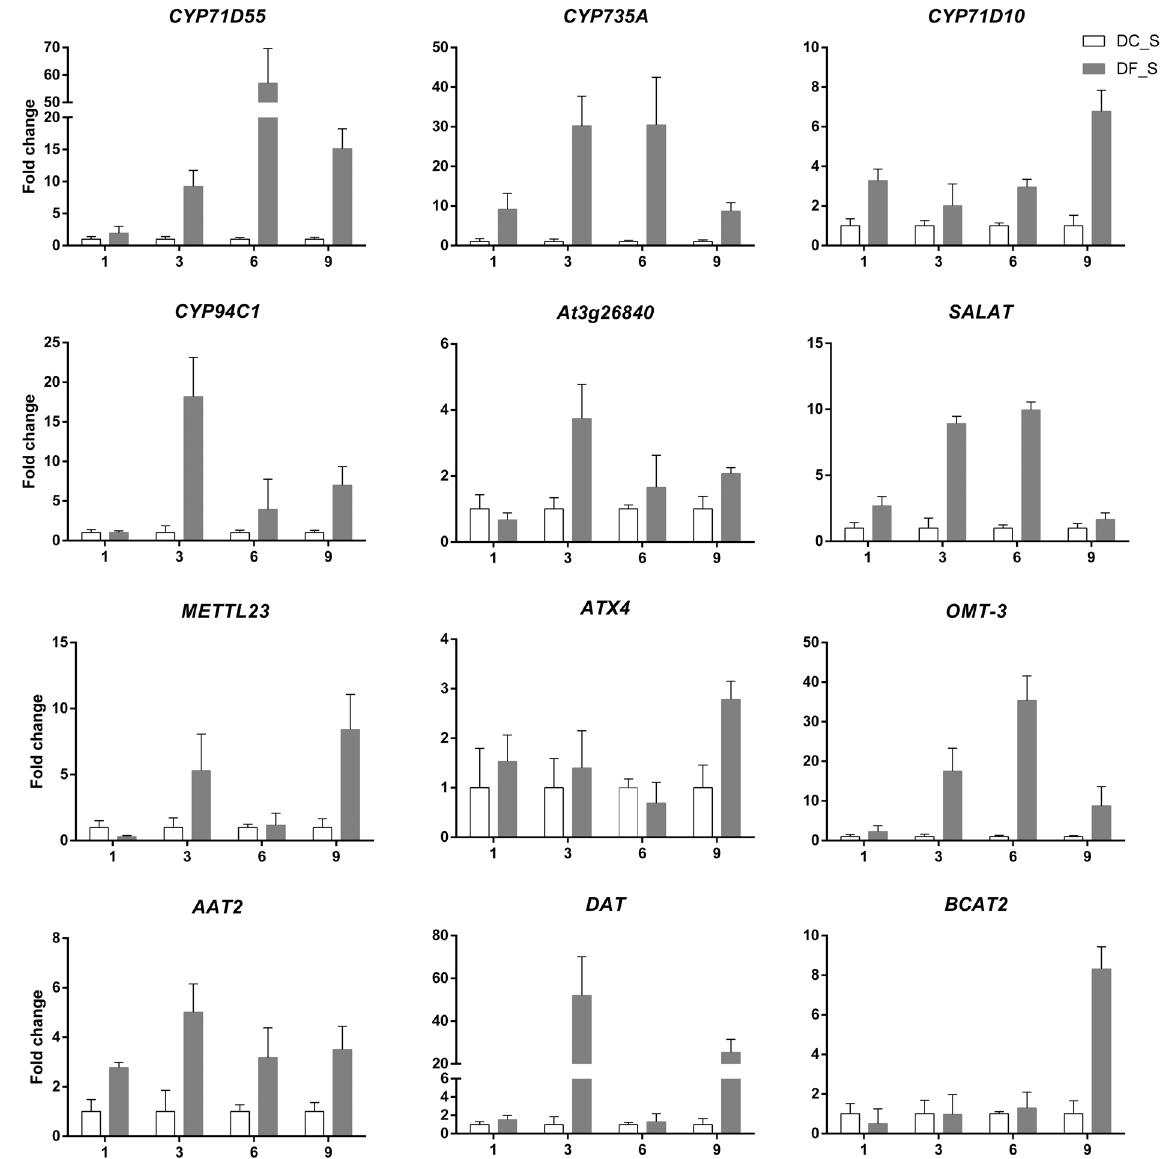
Figure 12. qRT-PCR analysis of key enzyme-coding genes involved in post-modification in D. nobile . The y-axes correspond to the mean fold changes of expression values, and the x-axes display the times of symbiotic culture (/weeks). White bars represent the control group (DC_S), and grey bars represent the model group (DF_S). For each qRT-PCR validation, three technical replicates were used, with a minimum of three biological